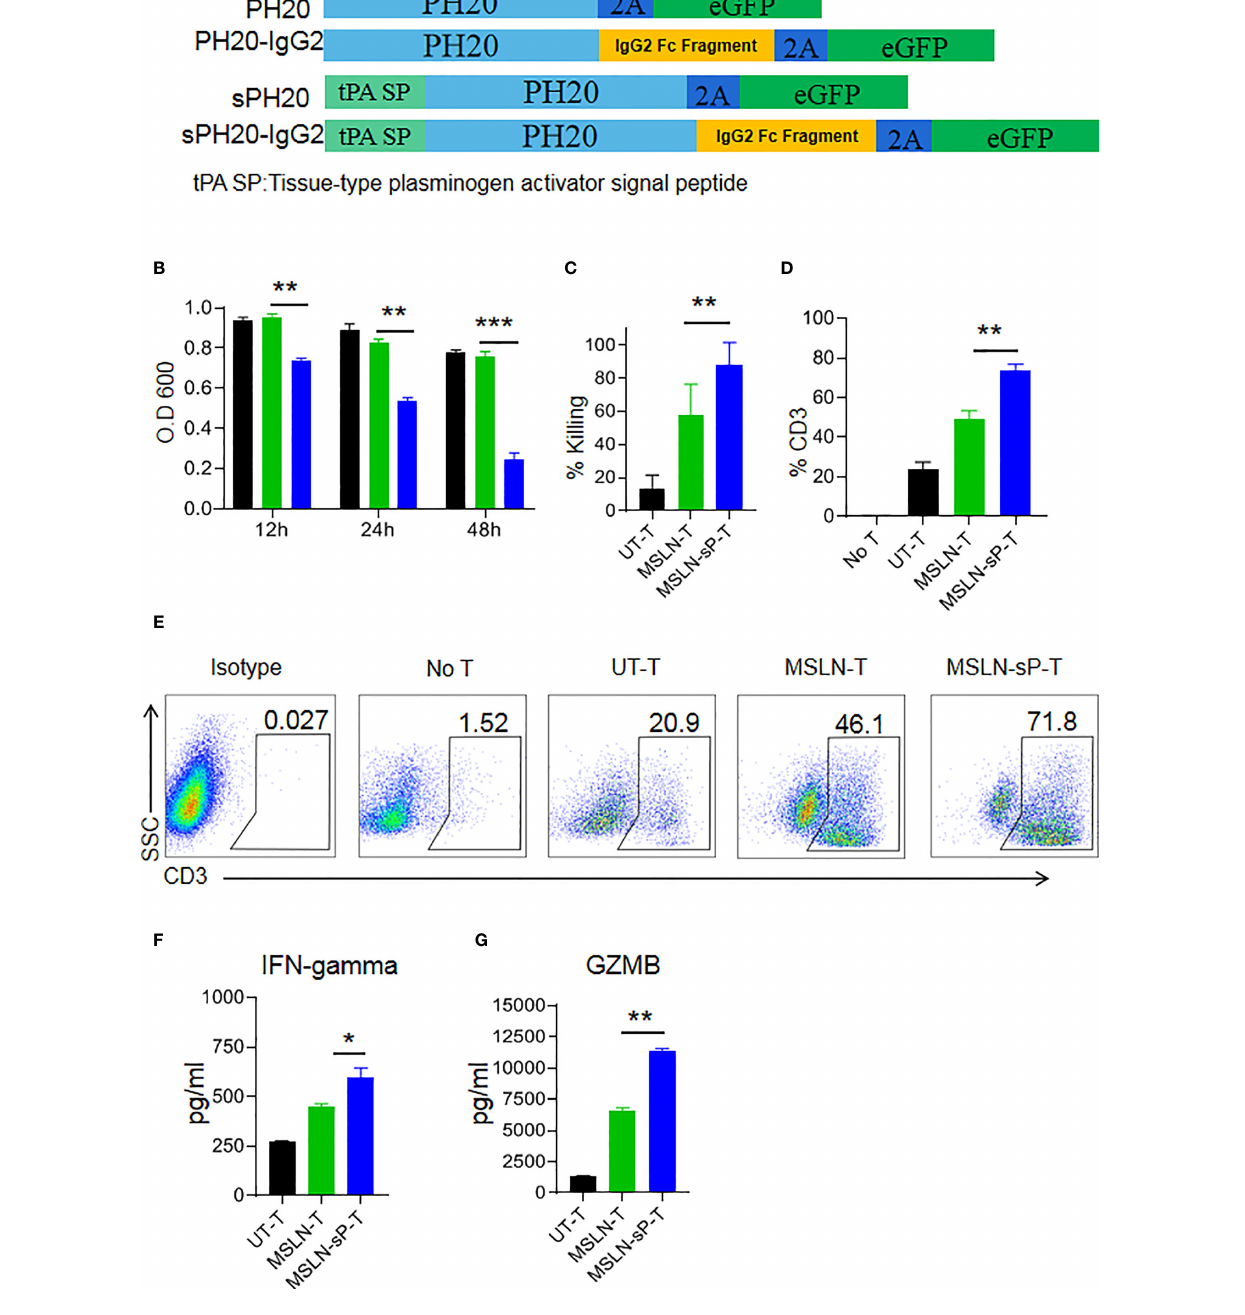
FIGURE 3 | sPH20-IgG2 enhances the transmigratory capacity of anti-MSLN CAR-T cells in an HA-containing matrix and promotes their antitumor activity in vitro. (A) Schematic diagram of the four types of PH20 lentiviral expression cassettes. (B) Hyaluronidase activity of UT-T, MSLN-T, and MSLN-sP-T cells; error bars denote the S. D, and the results were compared with an unpaired t test. *P<0.05; **P<0.01; ***P<0.001. (C) Viability of BGC823GL tumor cells in the lower chamber of a Transwell coculture system after coculture with UT-T, MSLN-T, or MSLN-sP-T cells at an E:T ratio of 1:1 with 5 mg/ml HA matrix in the upper chamber. (D) Percentage of CD3-positive T cells in the lower chamber of Transwell wells with UT-T, anti-MSLN-T, or anti-MSLN-sP-T cells at an E:T ratio=1:1 with 5 mg/ml HA matrix in the upper chamber. (E) Representative fl ow cytometry plot for (D) . (F) The concentrations of IFN- g and (G) granzyme B in the supernatant of chambers in the Transwell killing assay. Error bars denote the S. D, and the results were compared with an unpaired t test. *P<0.05; **P<0.01;